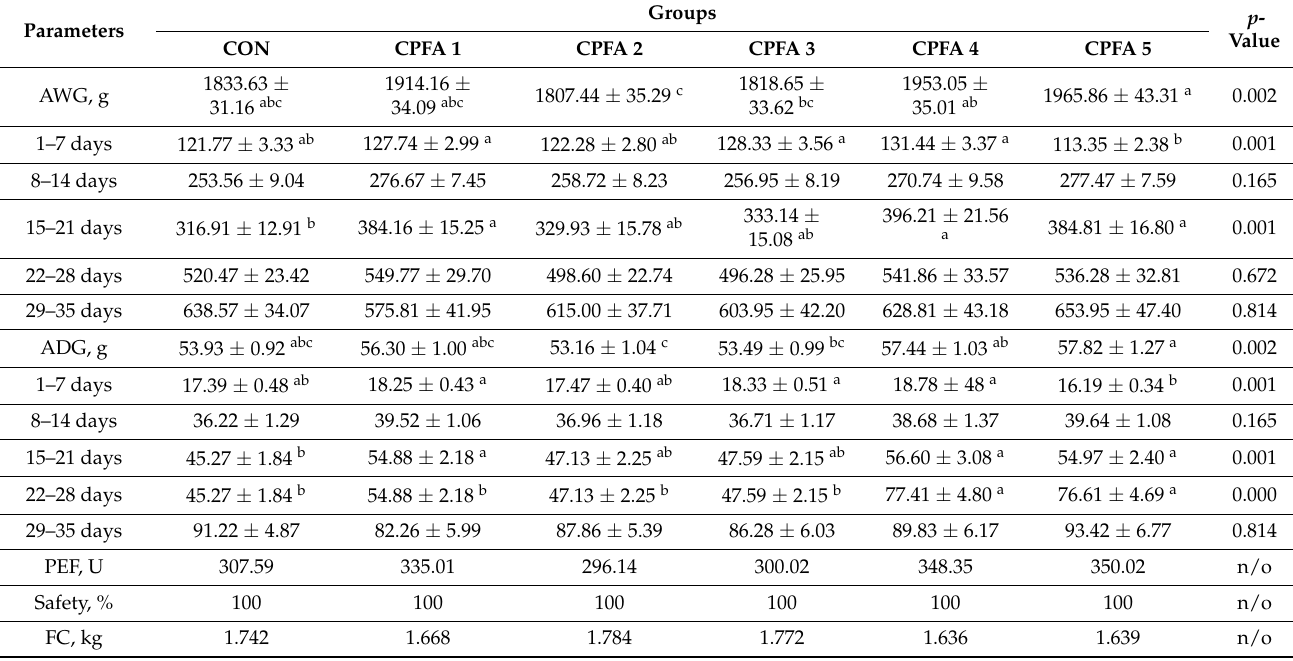
Table 5. Productivity indicators of Ross 308 cross broiler